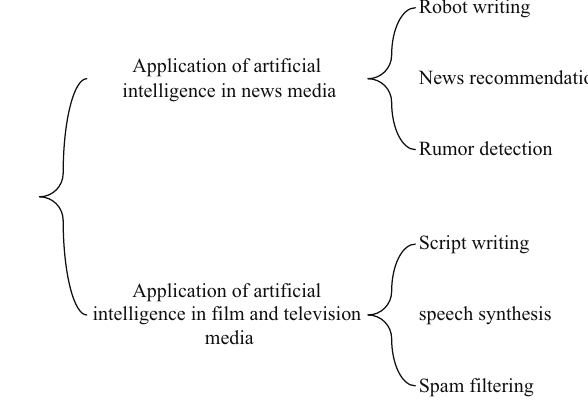
Figure 2: Application of arti fi cial intelligence in news media and fi lm and television